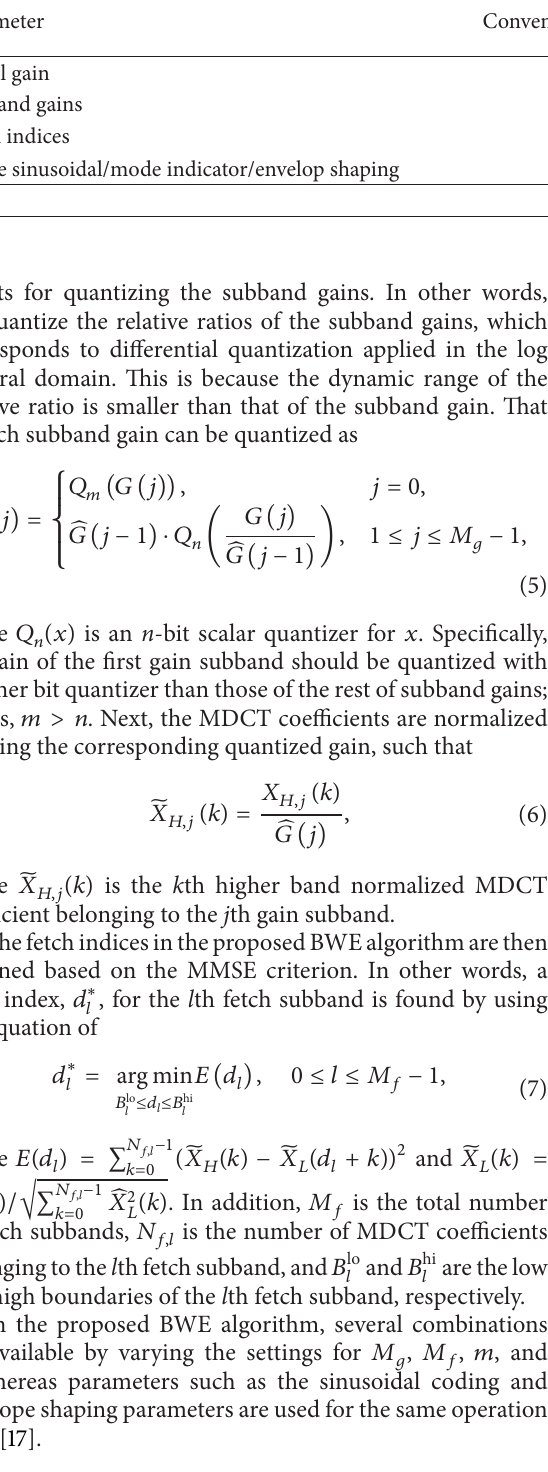
Table 1: Comparison of bit allocation between the conventional BWE algorithm and the proposed one with a typical set of the design parameters, where the algorithms are realized in the SWB extension of G.729.1 Annex E. Parameter Conventional BWE Initial